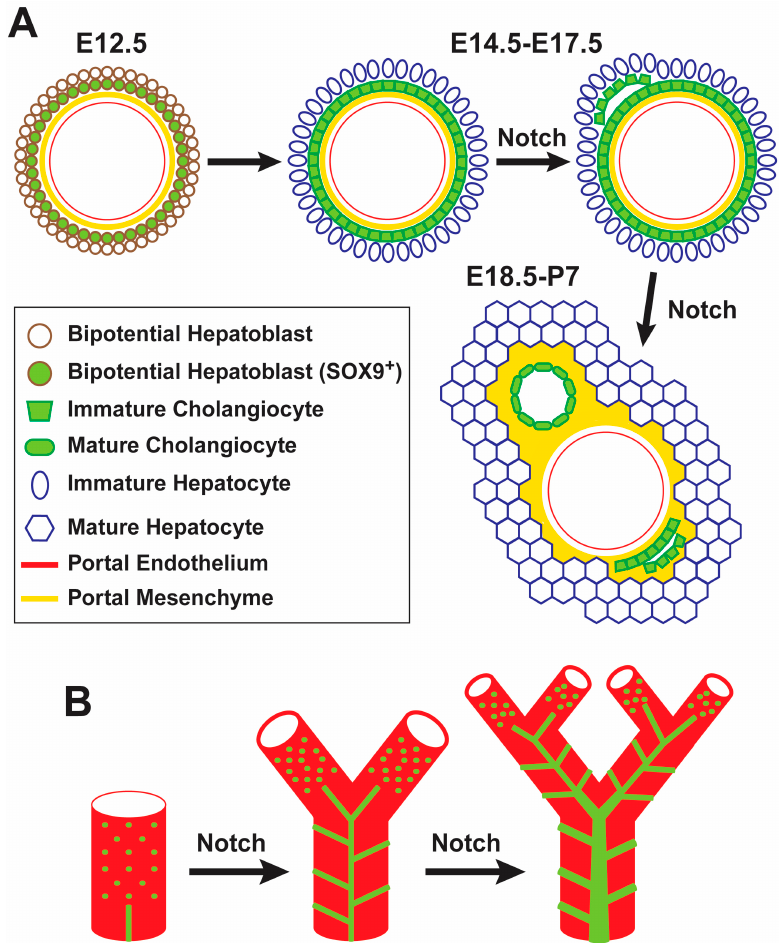
Figure 1. Notch signaling promotes biliary morphogenesis and the extension of the biliary tree. ( A ) A representation of cholangiocyte specification and biliary morphogenesis from E12.5 to the early postnatal period. ( B ) A three-dimensional (3D) representation of biliary development based on [17]. Differentiated cholangiocytes are first incorporated in a continuous homogeneous luminal network. This network is later reorganized into hierarchical tubular structures that form the adult biliary tree.